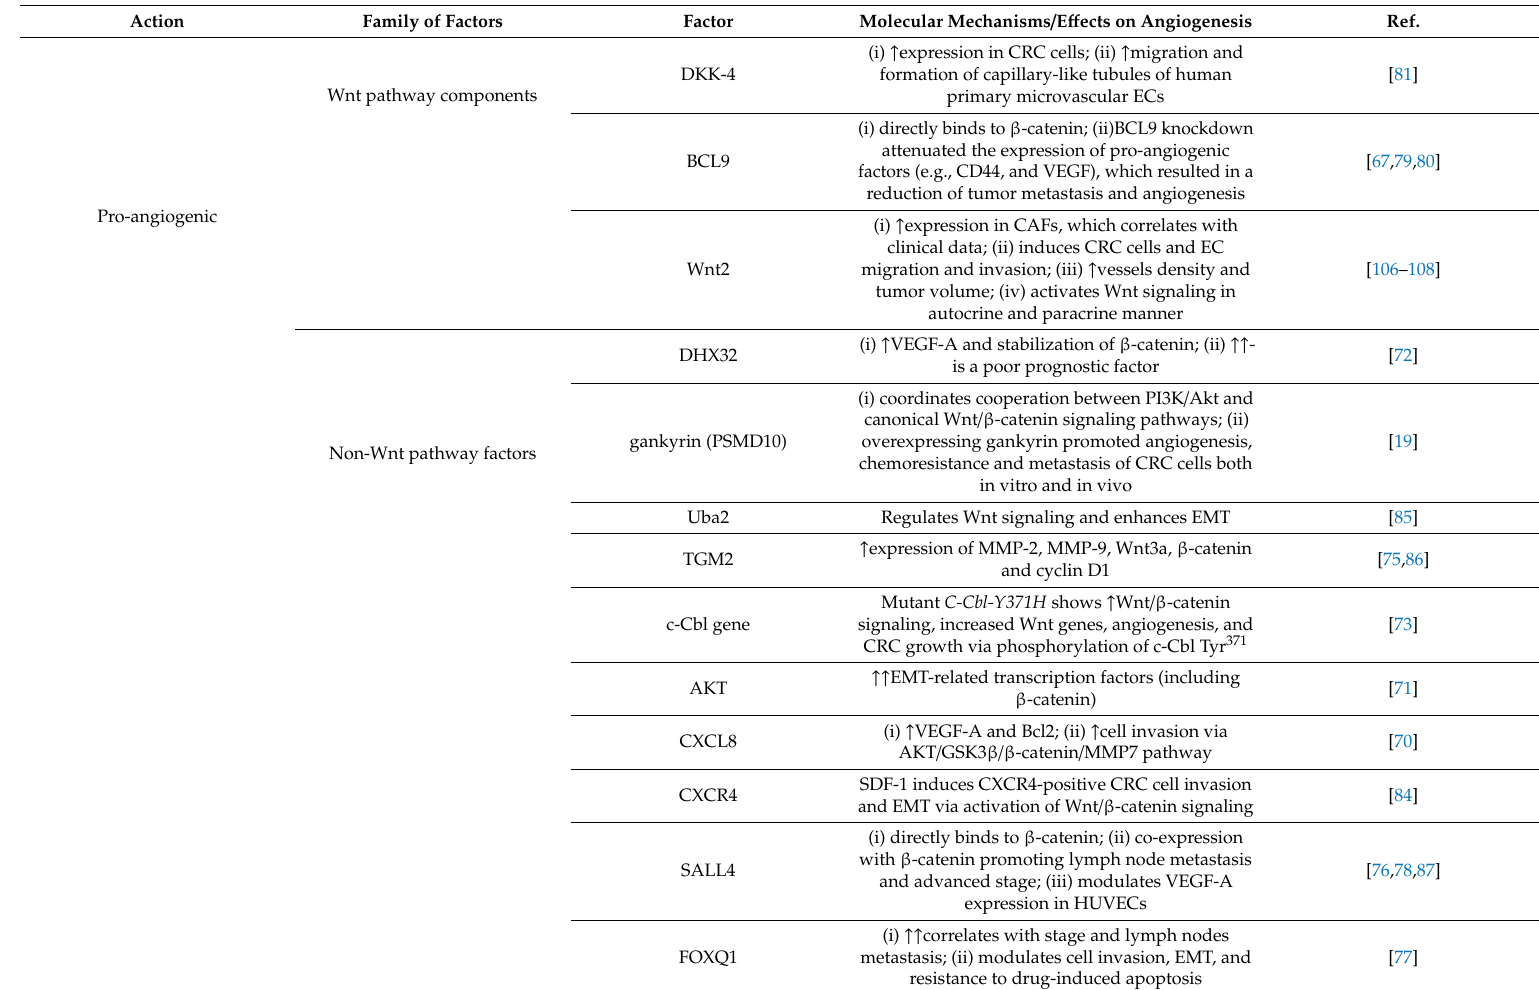
Table 1. A list of known pro- and anti-angiogenetic factors and their influence on the regulation of the Wnt / β -catenin signaling pathway in colorectal cancer (CRC)